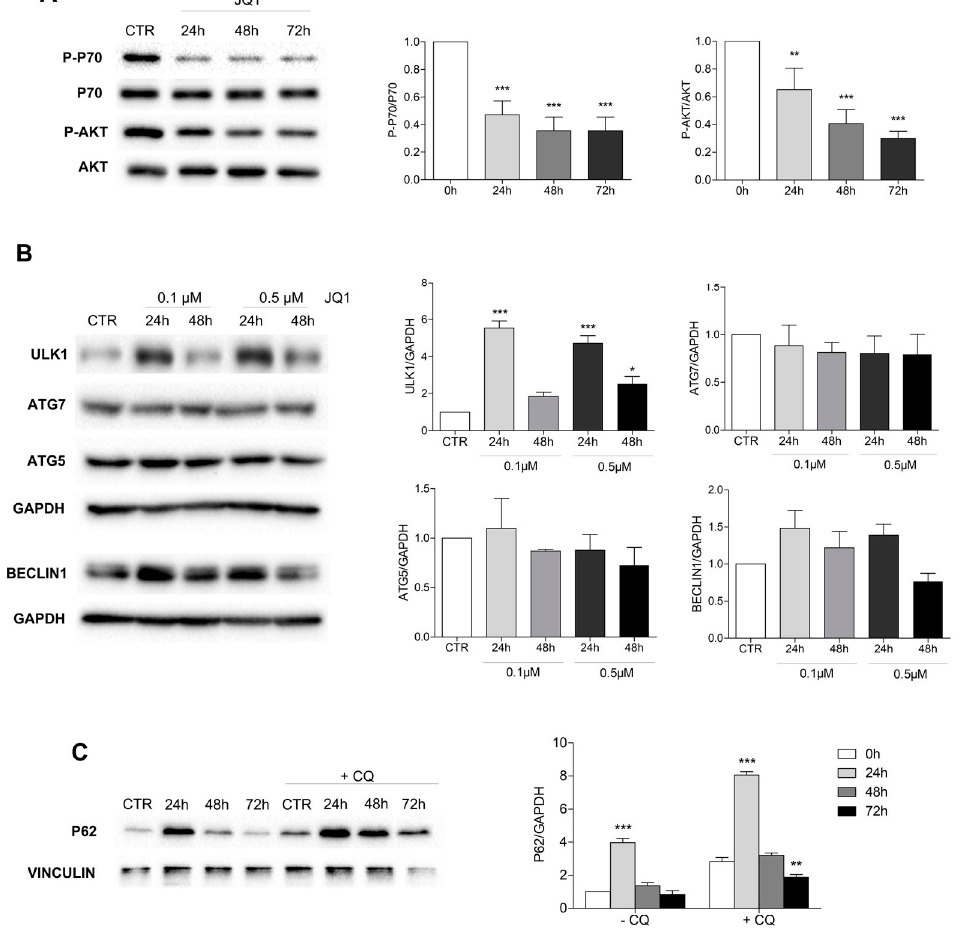
Figure 5. Autophagy is induced in JQ1-stimulated U87 cells. ( A ) U87 cells were cultured in complete DMEM (CTR) or in the presence of 0.5  M of JQ1 for 24, 48, and 72 h, and the corresponding protein extracts were analyzed by Western blo tt ing. The protein expression levels and activity of AKT1 and p70S6 were analyzed by using speci fi c antibodies for the phosphorylated and total forms of both proteins. Representative images of three di ff erent experiments are shown. VINCULIN was used as